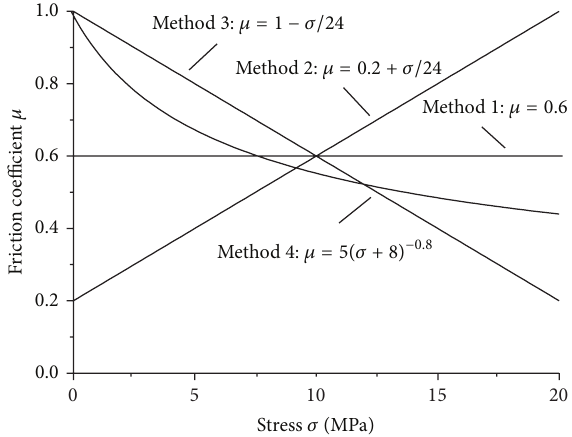
Figure 3: Choosing methods of the friction